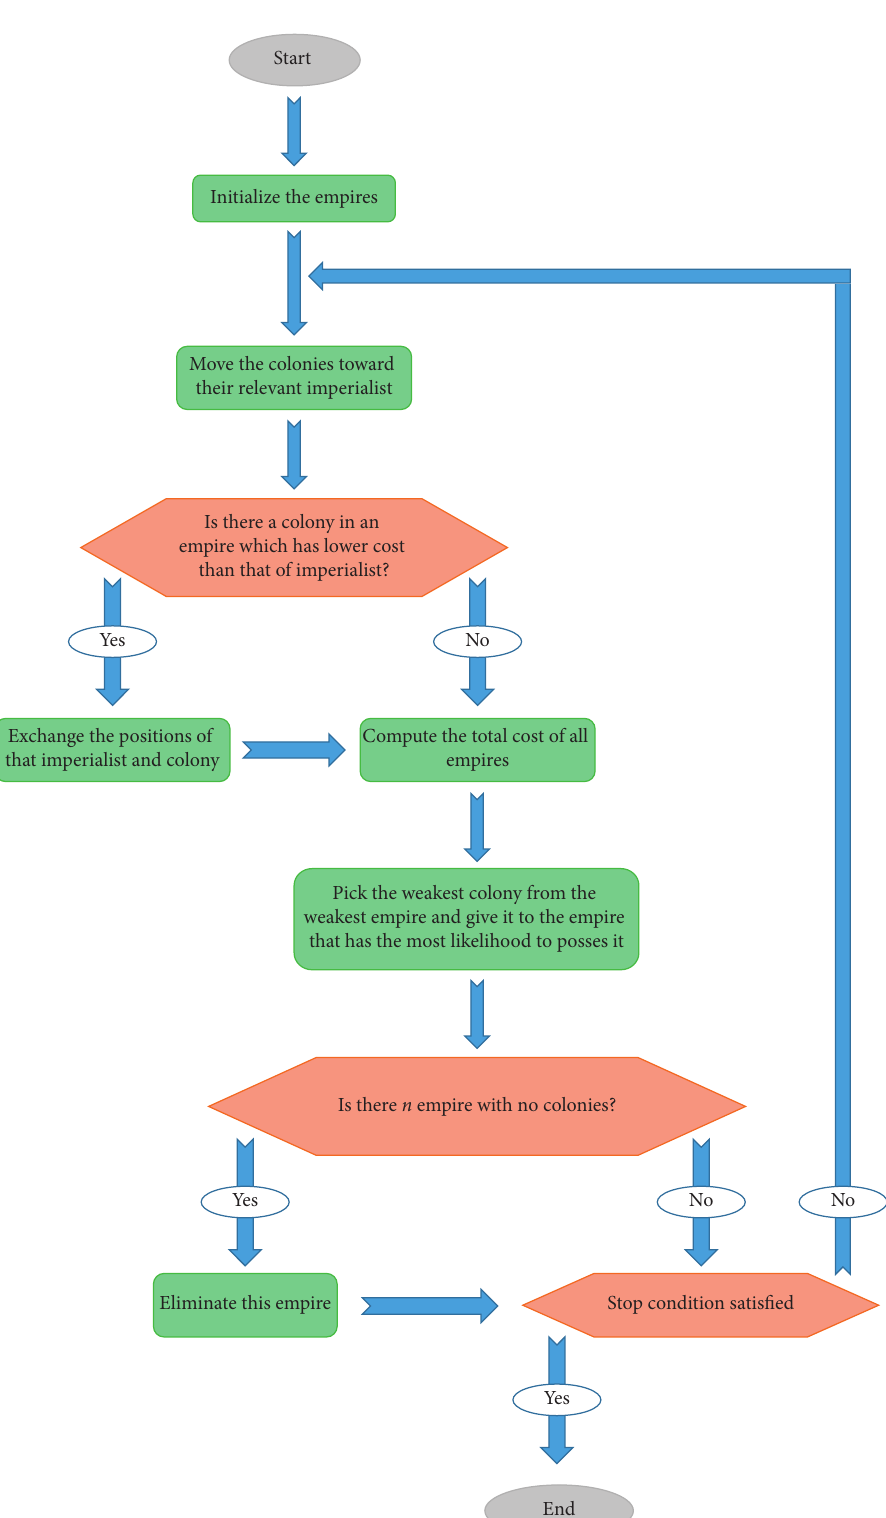
Figure 3: Flowchart of the ICA